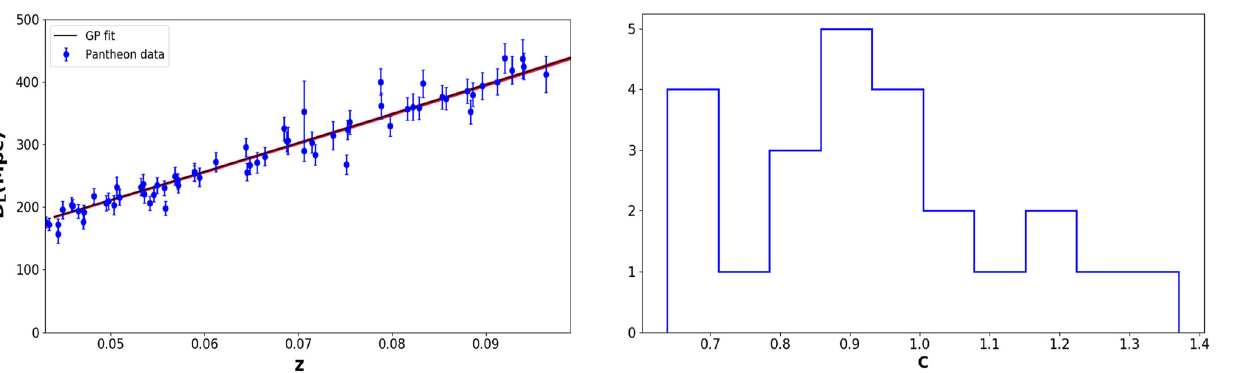
Fig. 3 The non-parametric reconstruction of luminosity distance as a function of z at cluster’s redshift. For this purpose, we use the Gaus- sian Processes Regression method [44]. The black line along with the crimson shaded region shows the GP fit and 1 σ error. The blue data points are Pantheon data in z < 0 . 1. For this plot we have assumed M B = − 19 . 253 ± 0 . 027 [37]